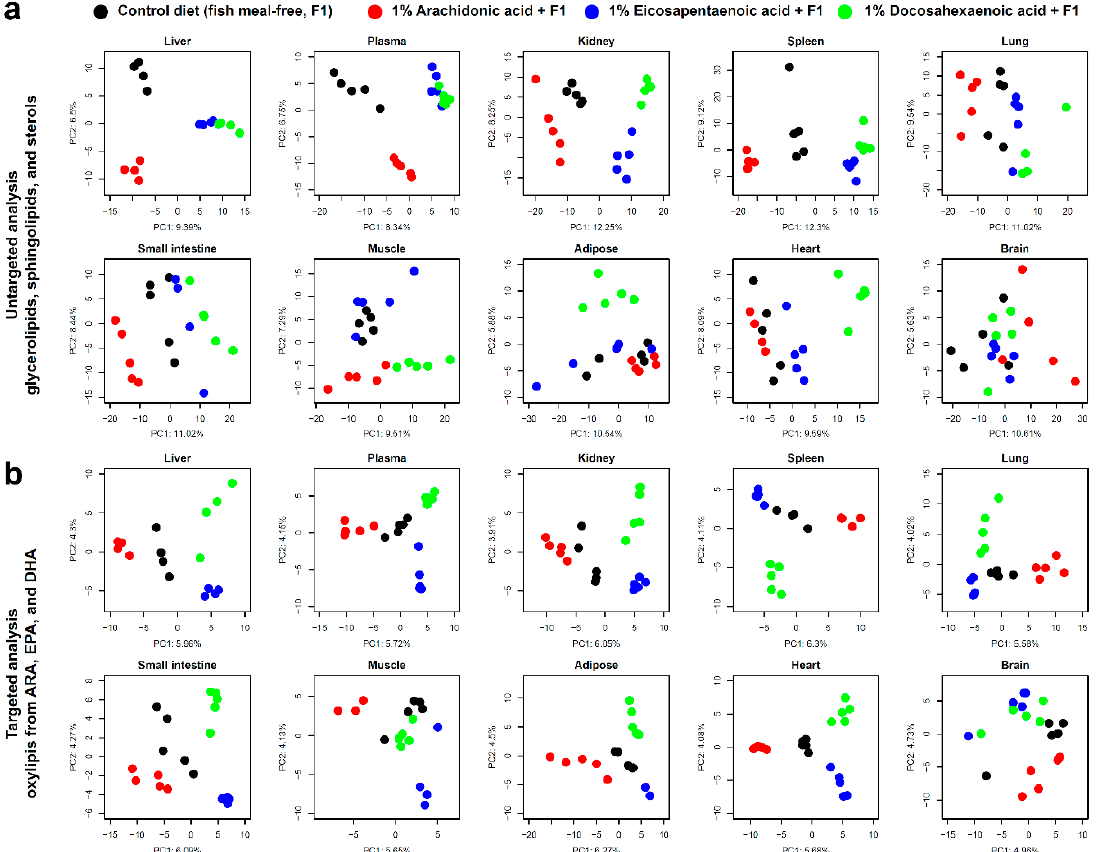
Figure 2. Principal component analyses (PCA) in untargeted and targeted lipidomics data. ( a ) The first and second principal components of PCA were described for plasma and all tissue metabolites obtained in the untargeted analysis. ( b ) The first and second components were also shown by the targeted lipidomics data. F1: fish-meal-free diet not containing ARA, EPA, or DHA.